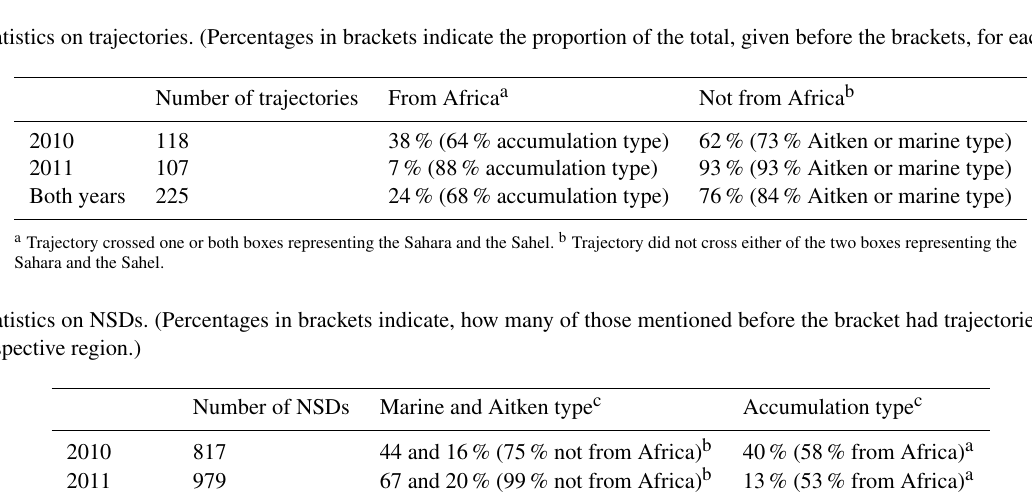
1796 57 and 18% (90% not from Africa) b 25% (57% from Africa) a a Trajectory arriving at the time of the NSD measurement crossed one or both boxes representing the Sahara and the Sahel. b Trajectory arriving at the time of the NSD measurement did not cross either of the two boxes representing the Sahara and the Sahel. c According to the characteristics given in Table